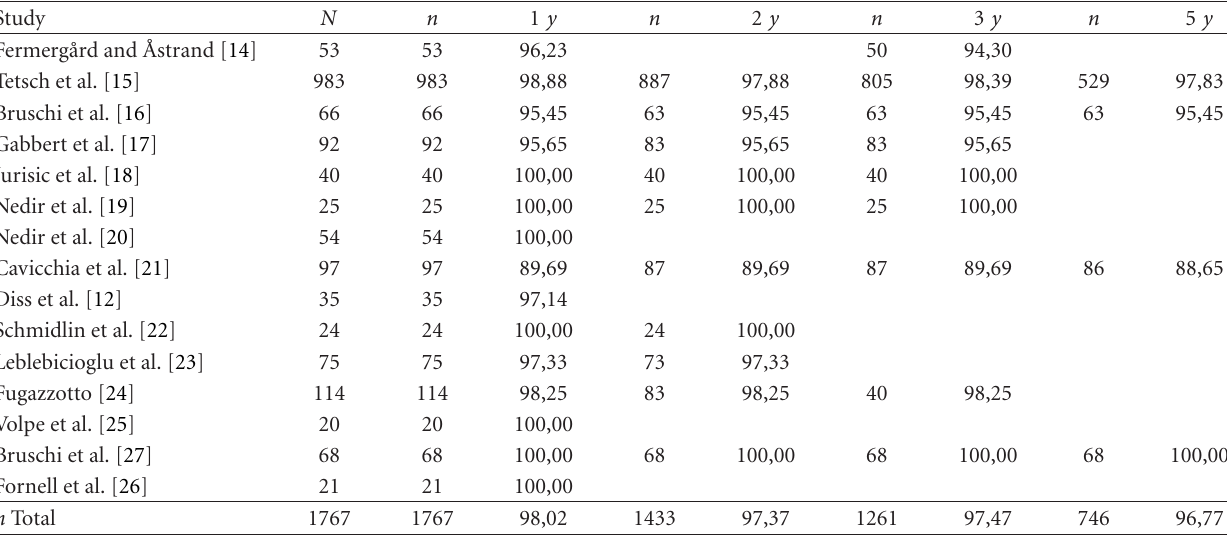
Table 1: Cumulative implant survival rates.